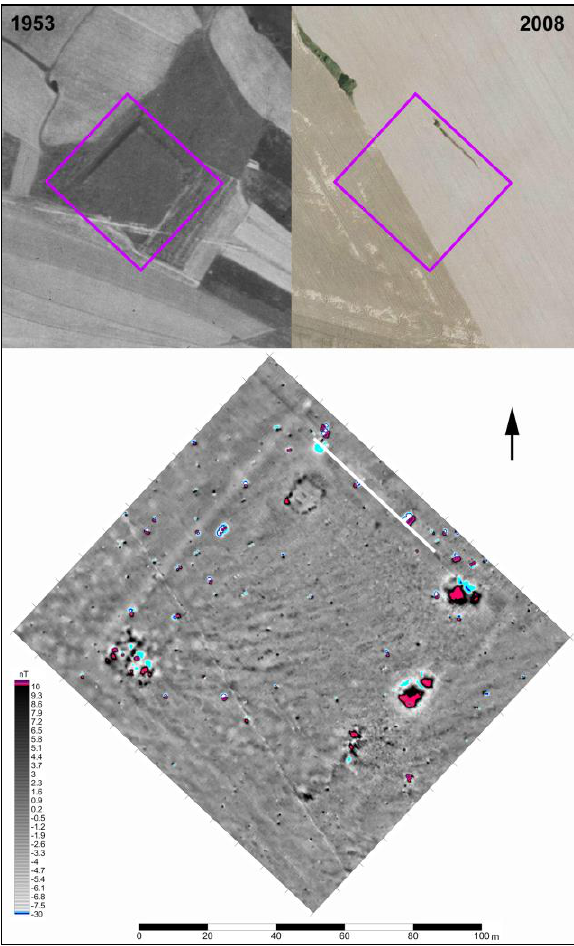
Figure 2. Třebsko, district Příbram. Comparison of details of aerial photographs of the site from 1953, 2008 and result of magnetometric measurement of ploughed out La Téne quadrangular enclosure (source of aerial photographs: www.kontaminace.cenia.cz; surveyed area: approx. 1.2 ha; geophysical survey: Křivánek 2012).